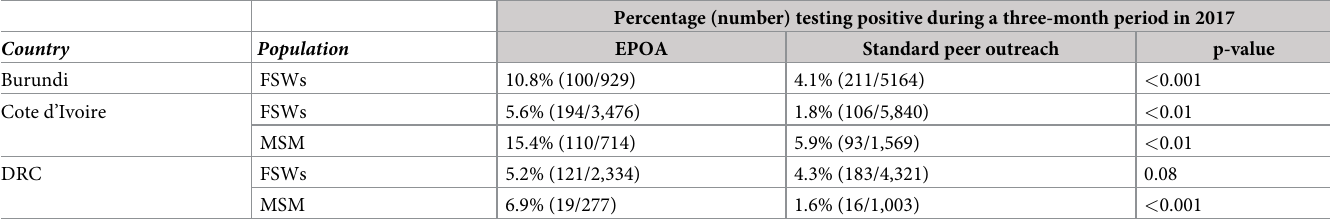
Table 2. HIV seropositivity in EPOA vs. standard peer outreach for FSWs and MSM in Burundi, Cote d’Ivoire, and DRC,